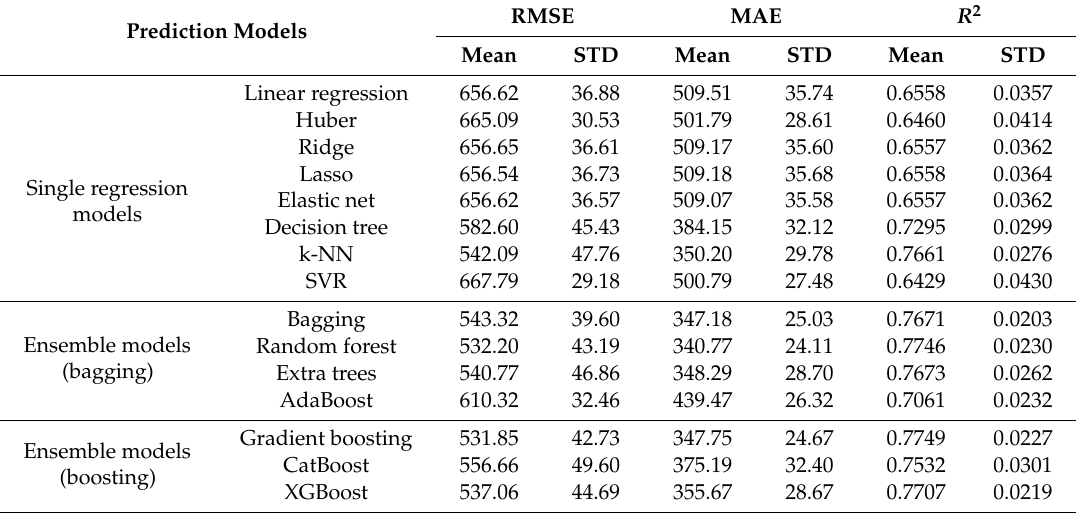
Table 6. Comparative statistics of prediction models based on forecast weather information using 10-fold cross-validation.